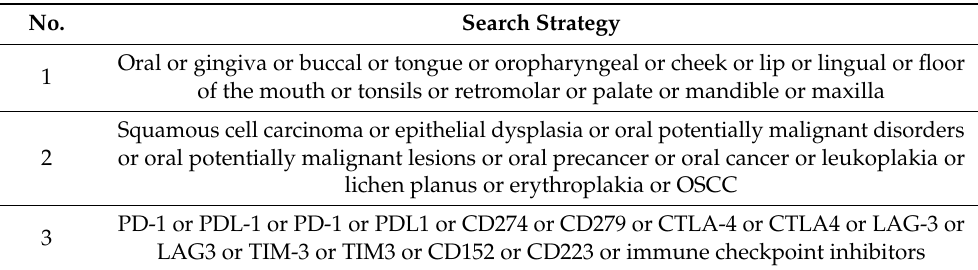
Table 1. Medical Subject Headings (MeSH) Terms for the Search Strategy. No. Search